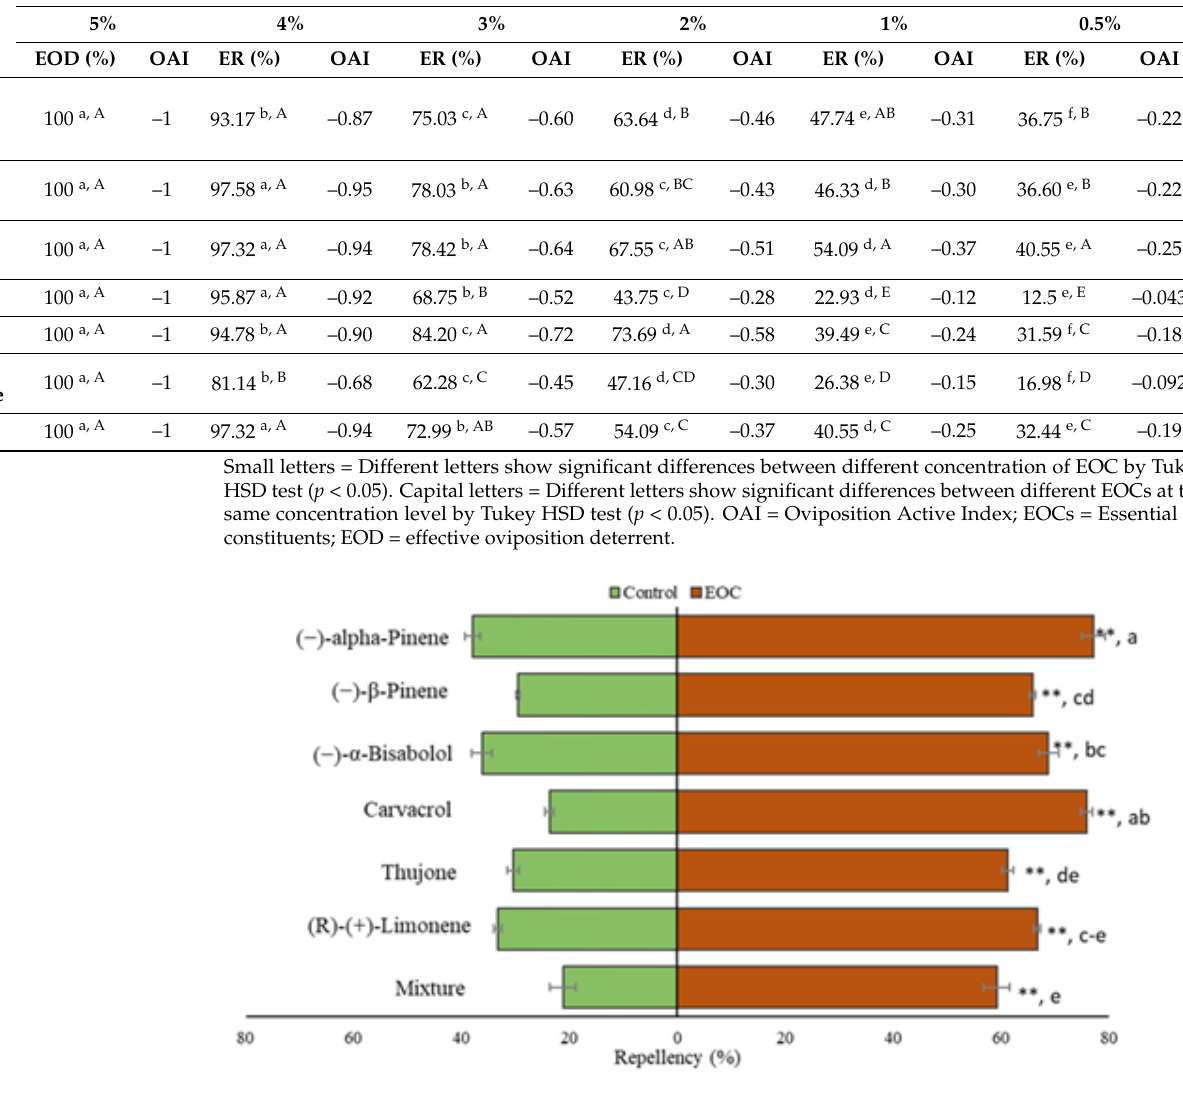
Figure 1. Response of B. dorsalis adults to the EOCs against control in a Y-tube olfactometer study. Bars marked with ‘**’ represent significantly greater repellency by EOC than control by χ 2 analysis at p < 0.05. “Alphabets” on each bar represent significantly different responses between the different EOCs at the same concentration by Kruskal-Wallis H-test (at p <